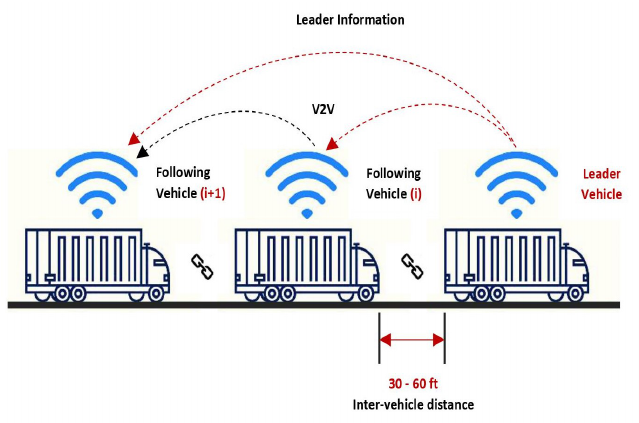
Figure 6. Illustration of platoon